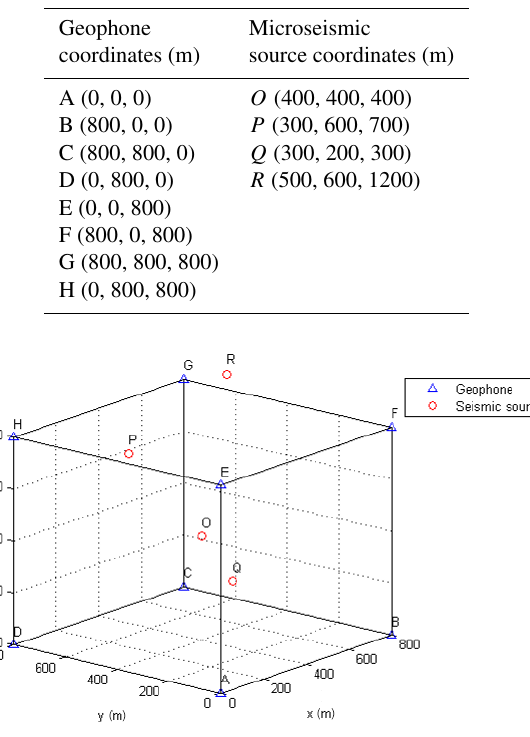
Table 1. Coordinates of sensors and microseismic sources.